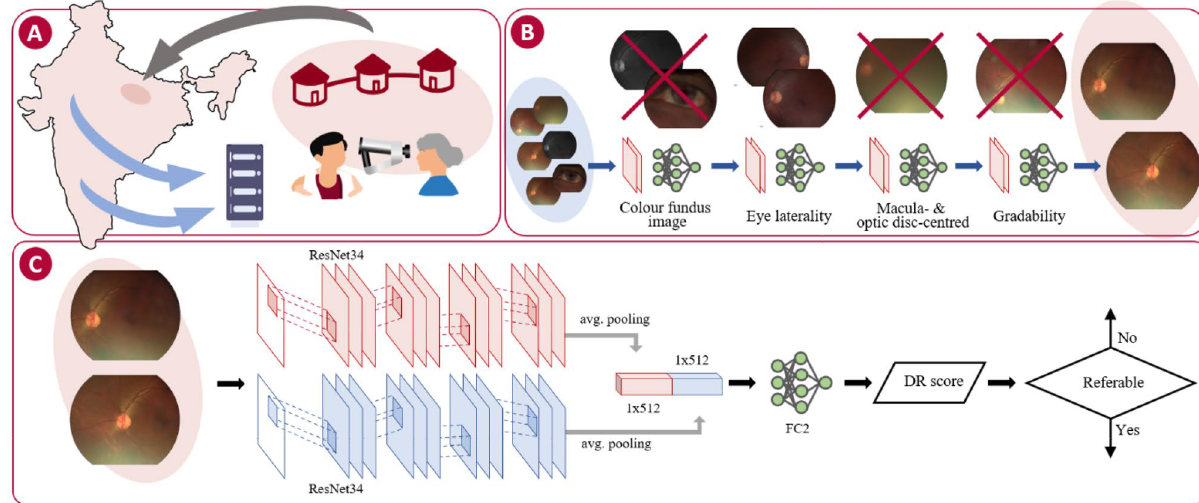
Figure 1. ( A ) Handheld non-mydriatic fundus images are captured by field workers in a community-based study across 20 sites in India. Images are uploaded to a cloud-based central database for independent manual grading at the study site (black arrow) and double graded and arbitrated at the four reading centres (blue arrows). ( B ) An automated pipeline comprising four independent deep learning models is used to curate the retinal for DR grading: fundus image detection, eye laterality detection, gradeability scoring, and field detection. ( C ) Model for automated referable DR grading of retinal photographs: two ResNet34 24 encoders independently trained extract features from each retinal field followed by global average pooling. The resulting feature maps were concatenated (1 × 1024) and followed by a fully-connected layer for classification (FC2). (Adobe Photoshop CS6 v13.0.1 http:// www. adobe.